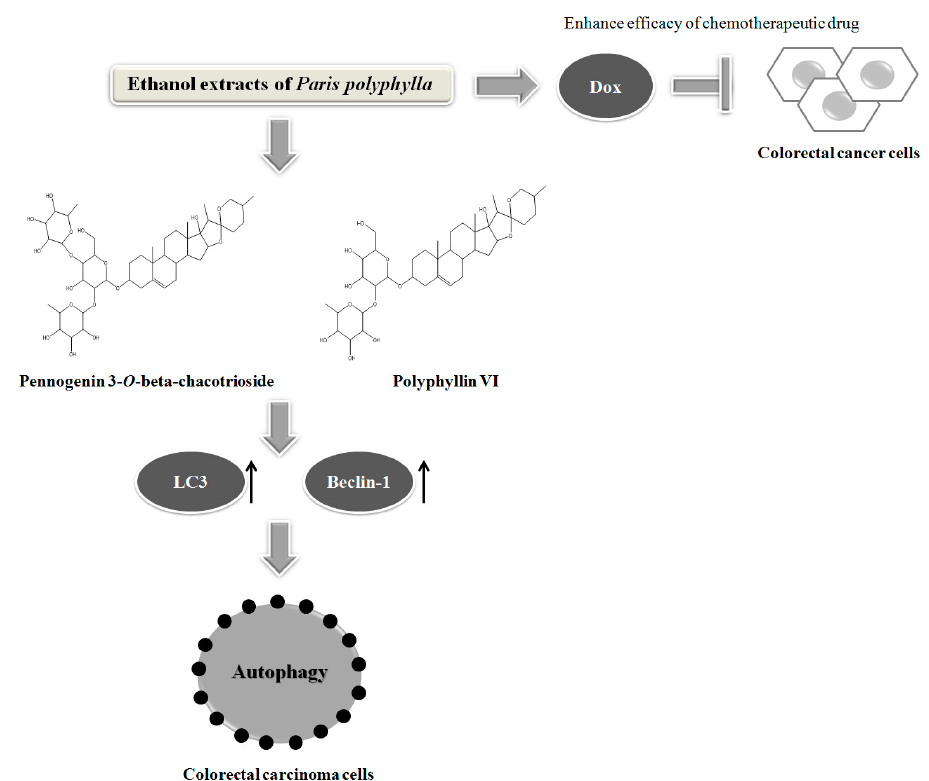
Figure 9. Schematics of the mode of action of Paris polyphylla ethanol extract on DLD-1 colorectal cancer cells.